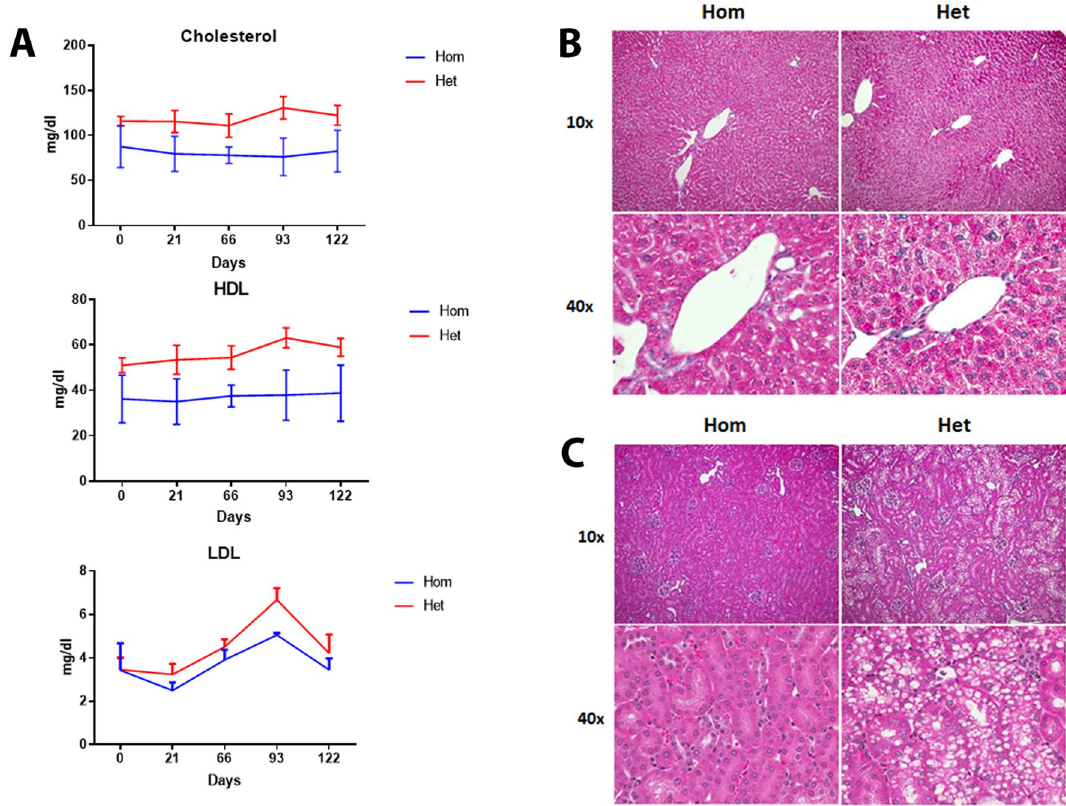
Figure 3. Liver and kidney histopathology and analysis of sera lipid values. ( A ). Analysis of serum total cholesterol, HDL and LDL in Hom and Het mice at various timepoints. The graphical data are represented as mean ± SD. (n = 7/group) (Hom vs Het mice—*** p ≤ 0.0008 Cholesterol and HDL levels, * p = 0.02 LDL levels) (n = 7 mice/group). ( B ) Representative liver and H&E-stained images. Corresponding liver histopathology was mostly unremarkable between the two groups except for subtle microvesicular change in the periportal hepatocytes of Hom mice. ( C ) Representative kidney H&E-stained images. Renal images show distinct vacuoles in PCT epithelial cells of a Het mouse while these are absent in Hom